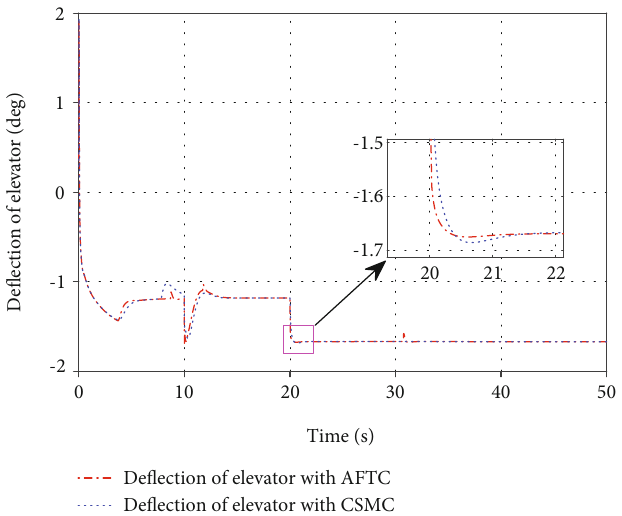
Figure 5: De fl ection of elevator in the presence of elevator fault in scenario 1.